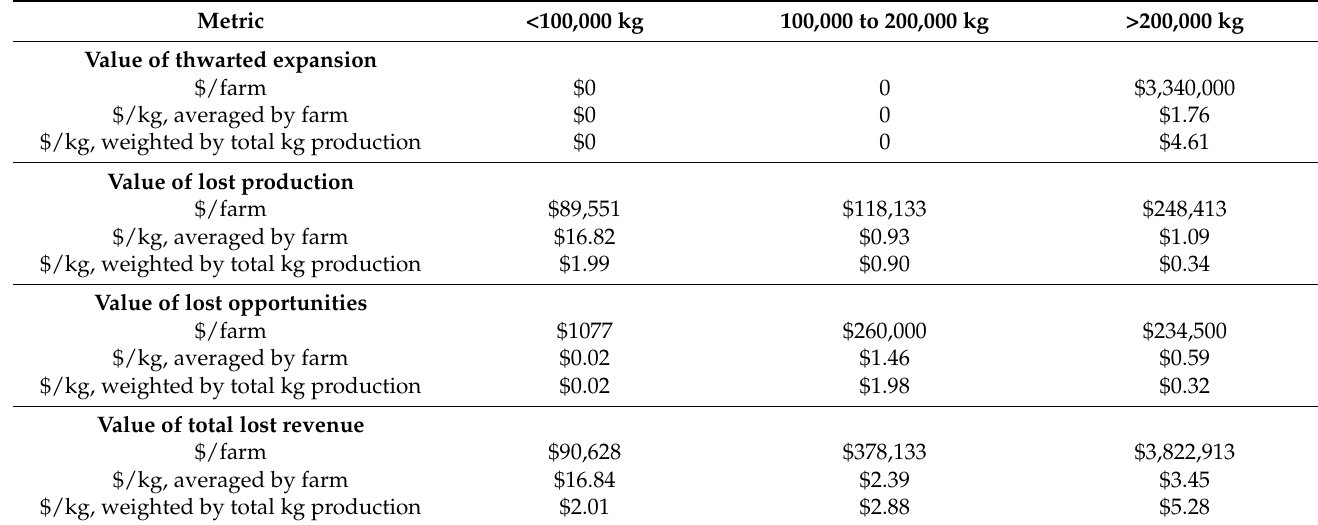
Table 15. Farm size effects of lost revenue.